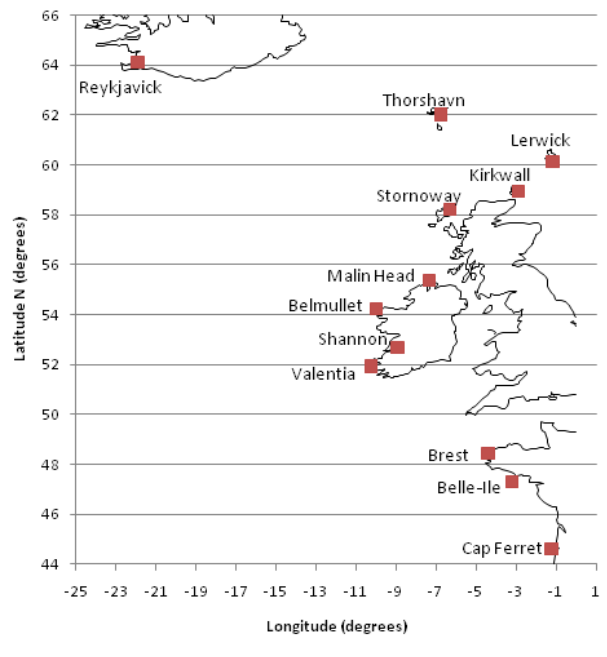
Fig. 1. Location map.